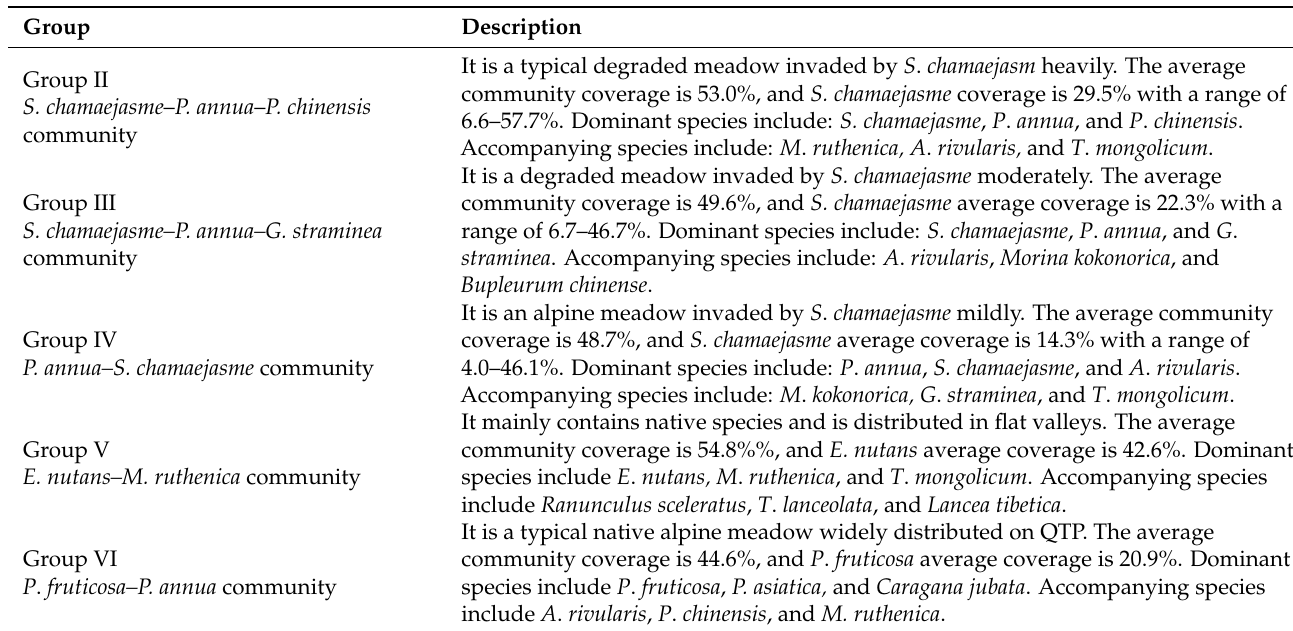
Figure 6. TD Mean values of the feature combing strategies. A: 5 bands+MI 13 ; B: 5 bands + MI 13 + NDI 23 + DI 23 ; C: 5 bands + MI 13 + DI 23 ; D: 5 bands+MI 13 +NDI 23 ; E: 5 bands ++ NDI 23 ; F: 5 bands + DI 23 ; G: 5 bands + NDI 23 + DI 23 ; H: 5 bands. 3.3. Spectral Adjustment of TWINSPAN Classes The importance value is adopted in the TWINSPAN vegetation classification in the study area, which is an integrative measure taking into account the coverage, height, and aboveground biomass of each species. However, the white-pink inflorescences make S . chamaejasm e distinguishable from surrounding green vegetation in the flowering phase, S. chamaejasme coverage is the most important factor in spectral discriminating S. chamae- jasme communities and the surrounding communities. TWINSPAN classification indi- cated the spectral conflicts between and within the plant communities. S. chamaejasme quadrats and the native species quadrats were grouped together; S. chamaejasme quadrats with high-, moderate-, and low-coverage were involved simultaneously in each of the three S. chamaejasme communities. The result implied the unsuitability of original TWIN- SPAN groups in further optimizing image classification. Therefore, TD is used to deter- mine the spectral separability of the six TWINSPAN communities and the quadrats are